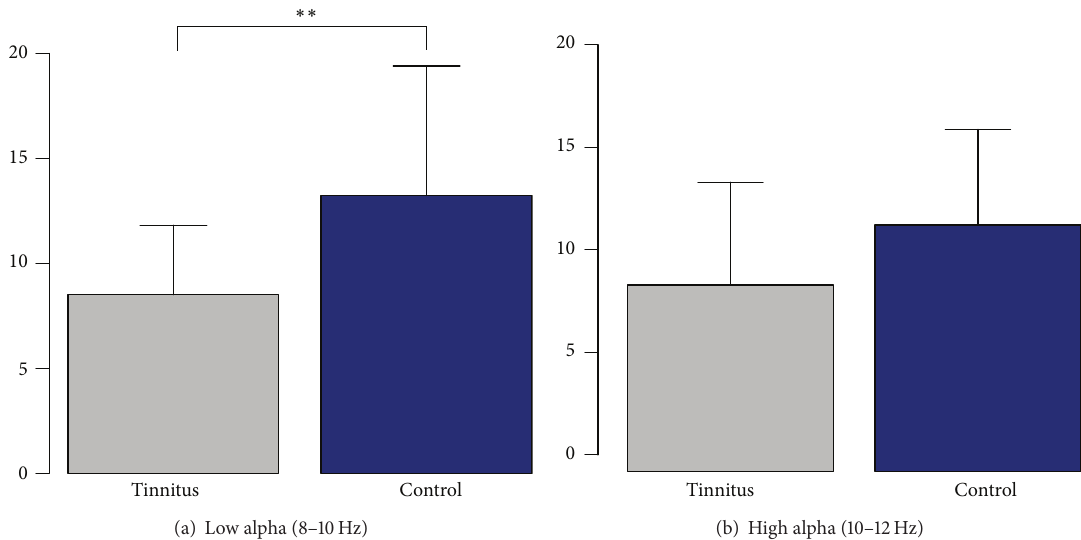
Figure 2: Alpha power group comparison. The bar plots demonstrate the group difference for the temporal alpha power for the lower alpha band from 8 to 10 Hz (a) and the upper alpha band from 10 to 12 Hz (b). The group difference is only significant for the lower alpha frequency range with 𝑃 = 0.0036 .